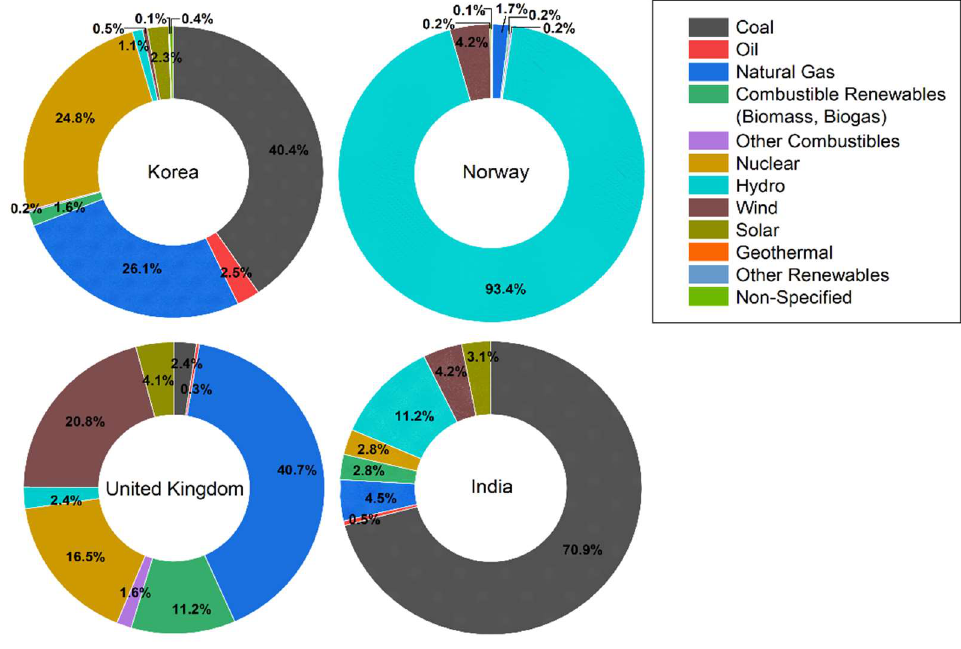
Figure 13. The proportion of electricity generation sources in four countries that have different percentages of resources used for national electricity generation. Table 10. Functional units of electricity produced in other sample countries.